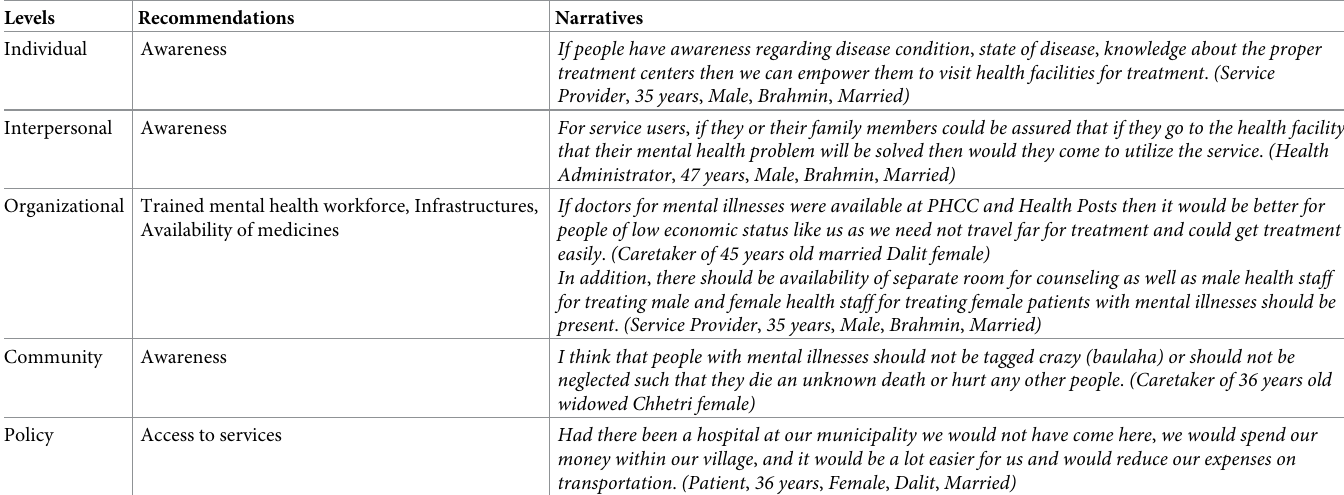
Table 3. Recommendations for improving mental health service utilization at PHC